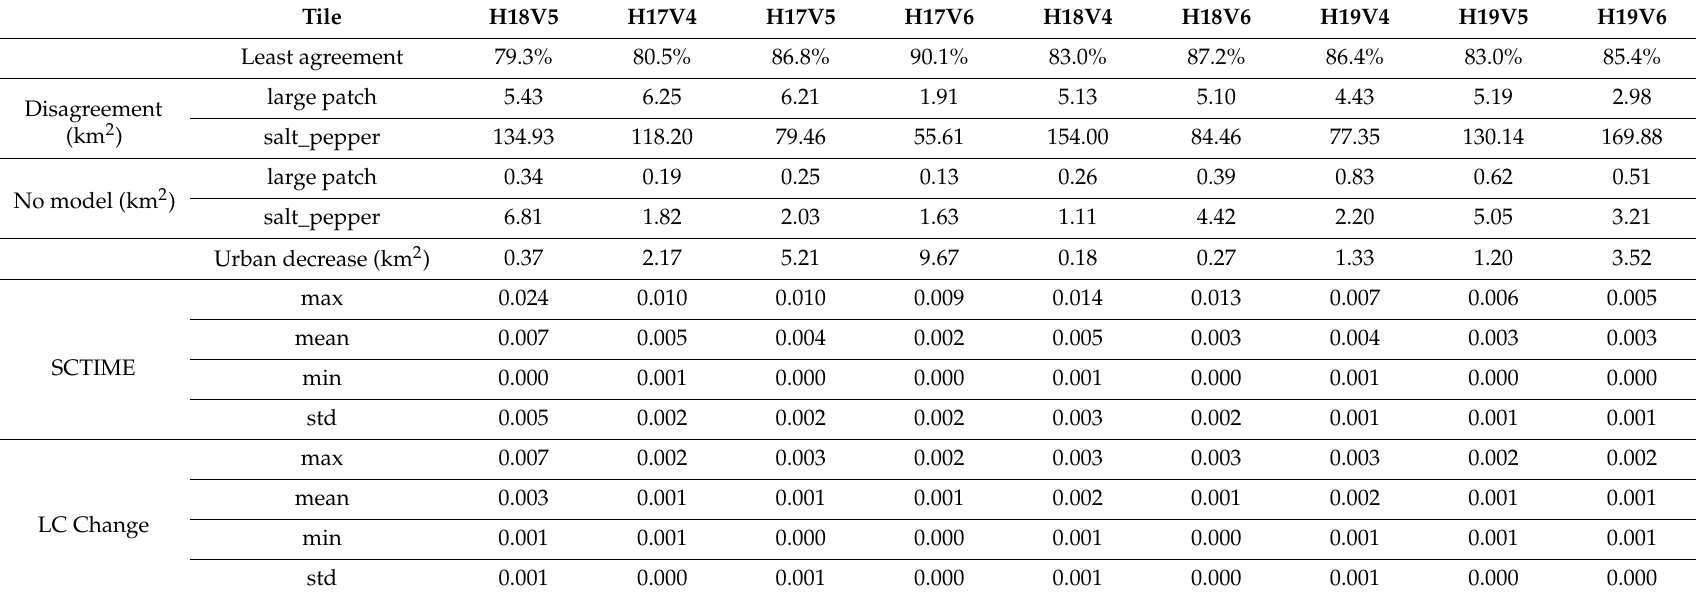
Table 4. Results of indices for H18V05 and its neighbor